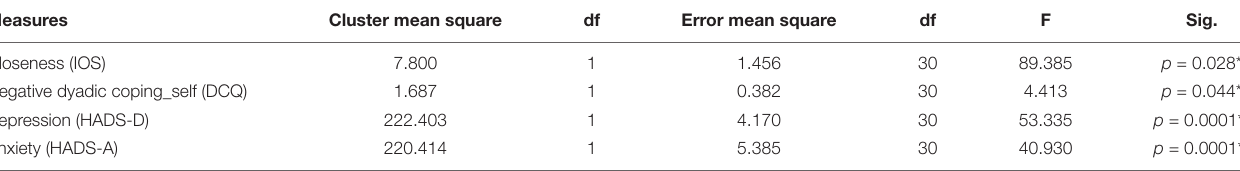
TABLE 4 | Cluster Analysis on partners’ subsample: